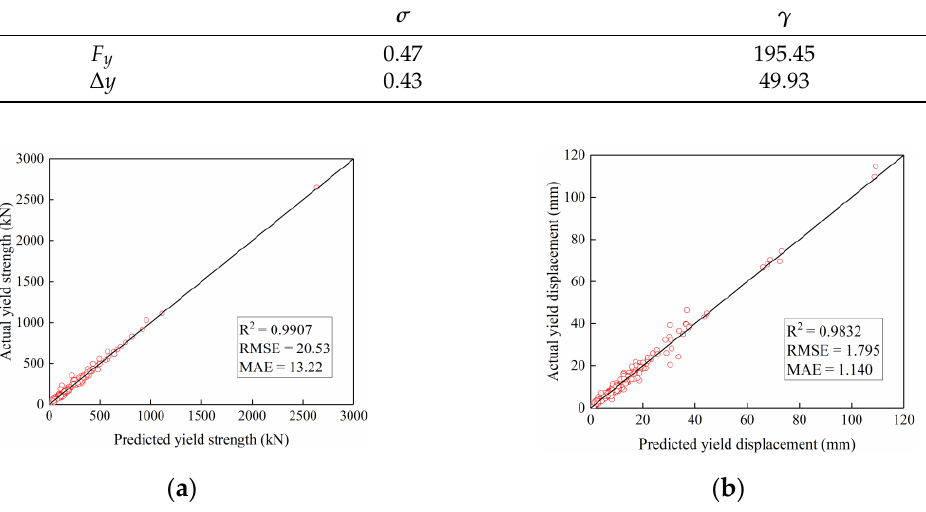
Figure 7. Training performance and result of PSO-LSSVM (number of samples = 305). ( a ) Yield strength; ( b ) Yield displacement.